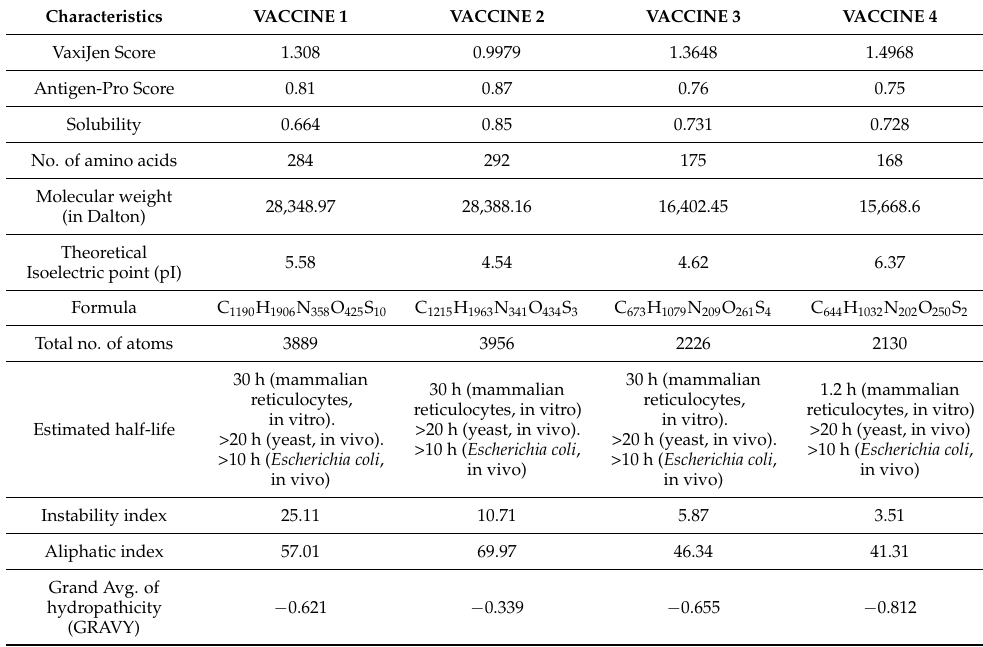
Figure 1. Schematic representation of the multi-epitope-based vaccine designed by linking the MHC-I and MHC-II epitopes of F. nucleatum with the different linkers and adjuvant. Table 3. In silico assessment of antigenecity, allergenicity, solubility, and physicochemical properties of the four designed vaccine